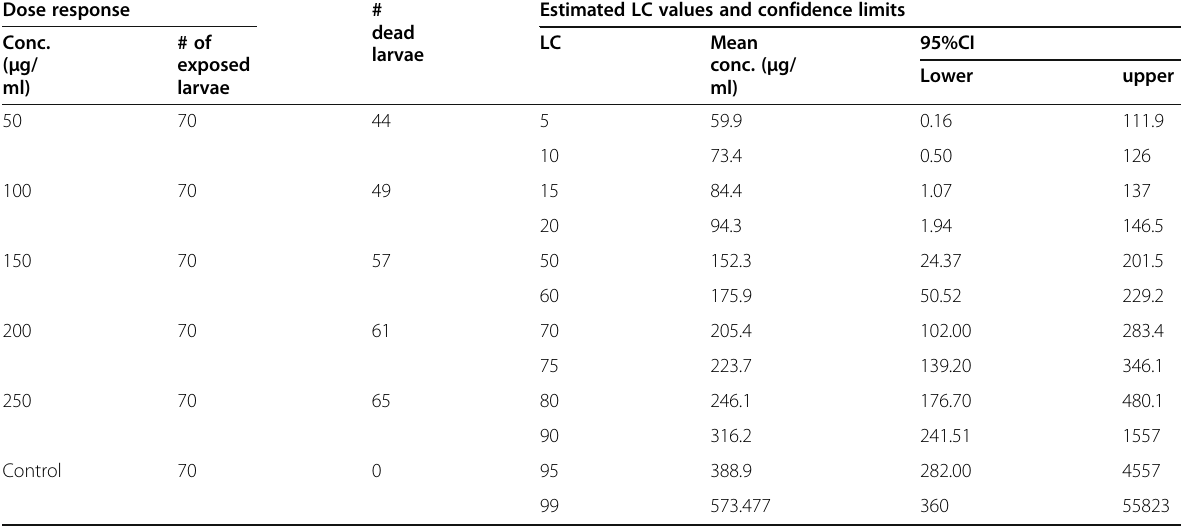
Table 5 In vitro hookworm larva killing effect of albendazole Dose